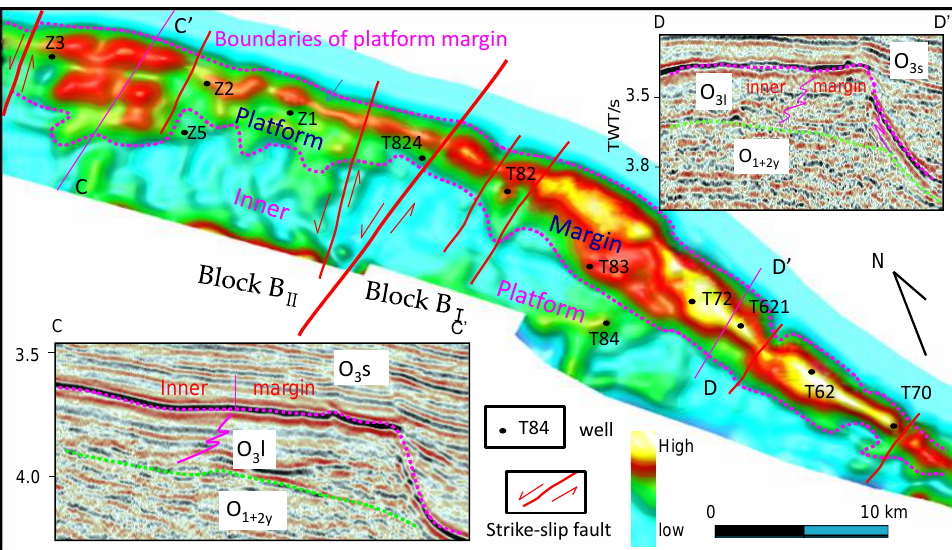
Figure 4. The palaeogeomorphic map of the reef – shoal complex of Lianglitage Formation along the northern platform margin (modified after reference [13,14]). The map and seismic profiles showing the reef – shoal segmentation and variation by the strike-slip faults (O 1+2y : Yingshan Formation; O 3 l: Lianglitage Formation; O 3 s: Sangtamu Formation; TWT: two-way traveltime).